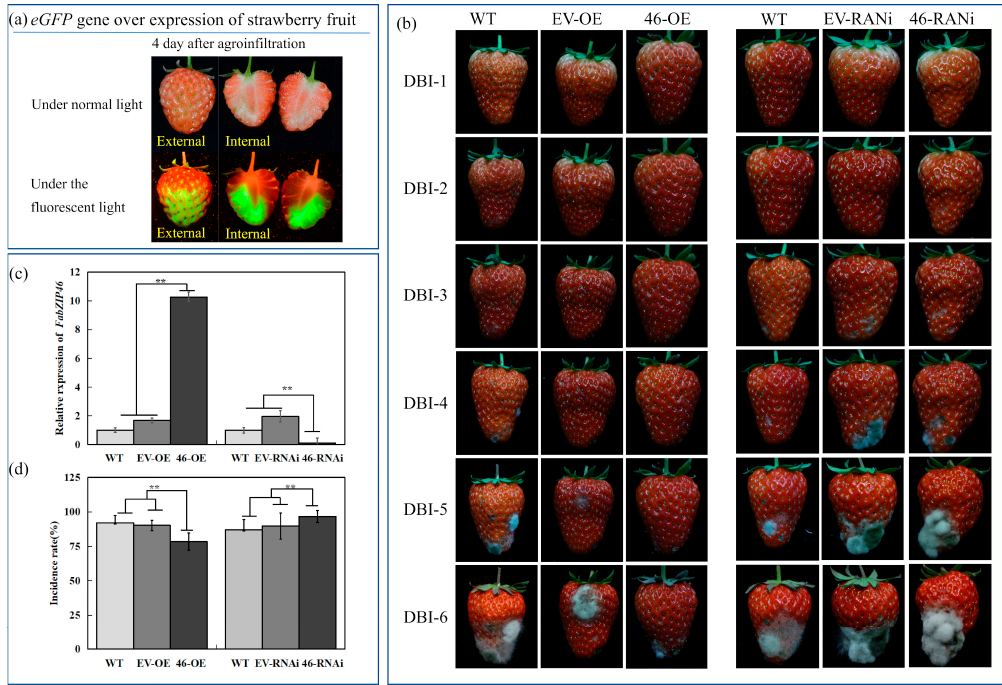
Figure 6. ( a ) Manipulated FabZIP46 gene expression levels in strawberries, obtained using transient overexpression and gene silencing techniques. Green fluorescence emitted by transformed strawberries was detected at four days after injection, indicating that the FabZIP46 gene was overexpressed or silenced in strawberries. ( b ) Phenotypes of FabZIP46-OE and FabZIP46-RNAi strawberries after Agrobacterium tumefaciens injection and Botrytis cinerea inoculation. Strawberries at the red stage of development were injected with A. tumefaciens , and B. cinerea inoculation was performed four days after A. tumefaciens injection. To avoid tissue damage that might affect the experimental results, approximately 1 mL (depending on the fruit size) of A. tumefaciens suspension was evenly injected into the fruits through the pedicel with a sterile hypodermic syringe. The injection depth was approximately half of the longitudinal diameter of the fruit to ensure that the A. tumefaciens suspension was fully released in the pith of the fruit. The first vertical line, second vertical line, fourth vertical line, and fifth vertical line represent the phenotypes of non-transgenic control fruits and transgenic fruits with empty vectors. The third vertical line and sixth vertical line show the phenotypes of transgenic fruits with FabZIP46-OE and FabZIP46-RNAi , respectively. ( c ) Changes in relative FabZIP46 gene expression levels in FabZIP46-OE and FabZIP46-RNAi fruits. Values are means ± SD ( n ≥ 3). Asterisks above the columns denote a significant difference at ** p < 0.05 levels according to the Student’s t -test. ( d ) Comparison of the incidence of FabZIP46-OE and FabZIP46-RNAi in strawberries after Botrytis cinerea inoculation.